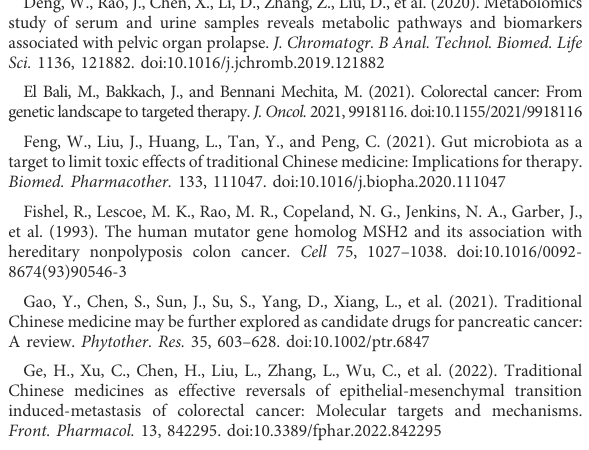
SUPPLEMENTARY FIGURE S1 PCA scores plot generated from the detected features across all colon tissues samples in the positive ( A ) and negative ( B ) modes, respectively. SUPPLEMENTARY FIGURE S2 The top 11 species in abundance at the phylum level for the tested fecal samples in CRC group and YQSJ group. SUPPLEMENTARY FIGURE S3 The top 11 species in abundance at the genus level for the tested fecal samples in CRC group and YQSJ group. SUPPLEMENTARY FIGURE S4 PCoA analysis of bacterial community structure in CRC group and YQSJ group. SUPPLEMENTARY FIGURE S5 The LDA score in LEfSe analysis of bacterial community structure in CRC group. SUPPLEMENTARY FIGURE S6 The cladogram in LEfSe analysis of bacterial community structure in CRC group. SUPPLEMENTARY FIGURE S7 Peiminine induced apoptosis in HCT-116 cells by using fl ow cytometry. SUPPLEMENTARY FIGURE S8 The top ten enriched terms for each category in GO enrichment analysis based on 1073 signi fi cantly changed